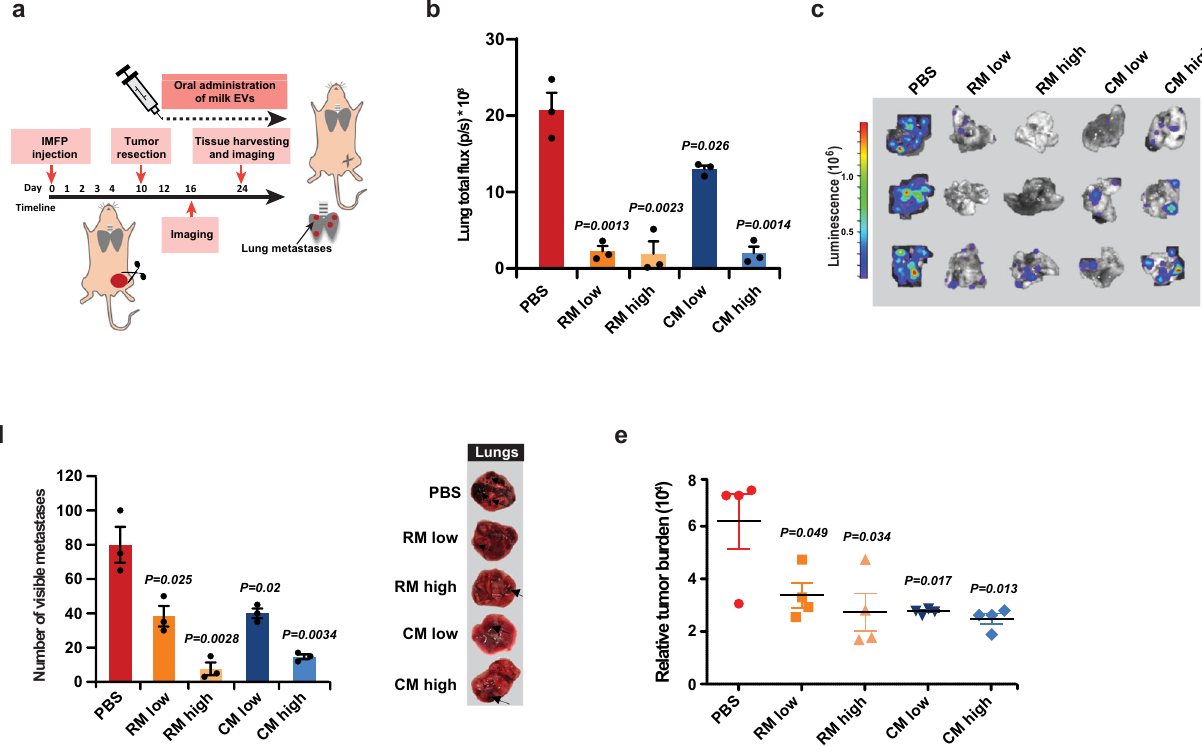
Fig. 7 Resection of primary tumor signi fi cantly reduces metastasis. a Schematic representation of tumor resection and treatment timeline with milk- derived EVs. b Total lung fl ux to quantify breast cancer metastasis is depicted ( n = 4). c Lungs were excised from the mice at the endpoint and subjected to bioluminescence. d Pathological examination of lung metastases and quanti fi cation of visible metastases on the surface of the tissue ( n = 4). e Relative metastatic tumor burden is depicted ( n = 4). All data are represented as mean ± s.e.m. Statistical signi fi cance was determined by unpaired two-tailed t